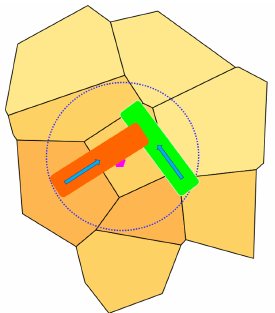
Figure 6. Two examples of Buffered Linear Regressions . The red one is a landslide . The arrows show the direction of the movement of the landslide, in case of